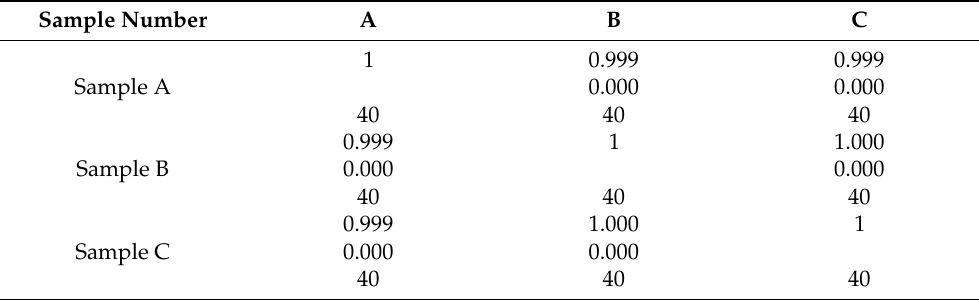
Table 8. Correlation test table of Mayuan Zn-Pb deposit (pearson correlation significance). Sample Number